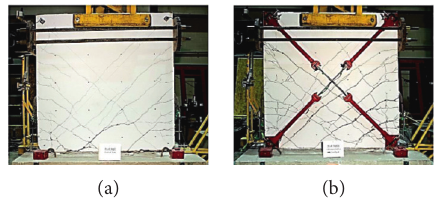
Figure 9: Cracks developed in a reinforced concrete panel with an A36 bracing